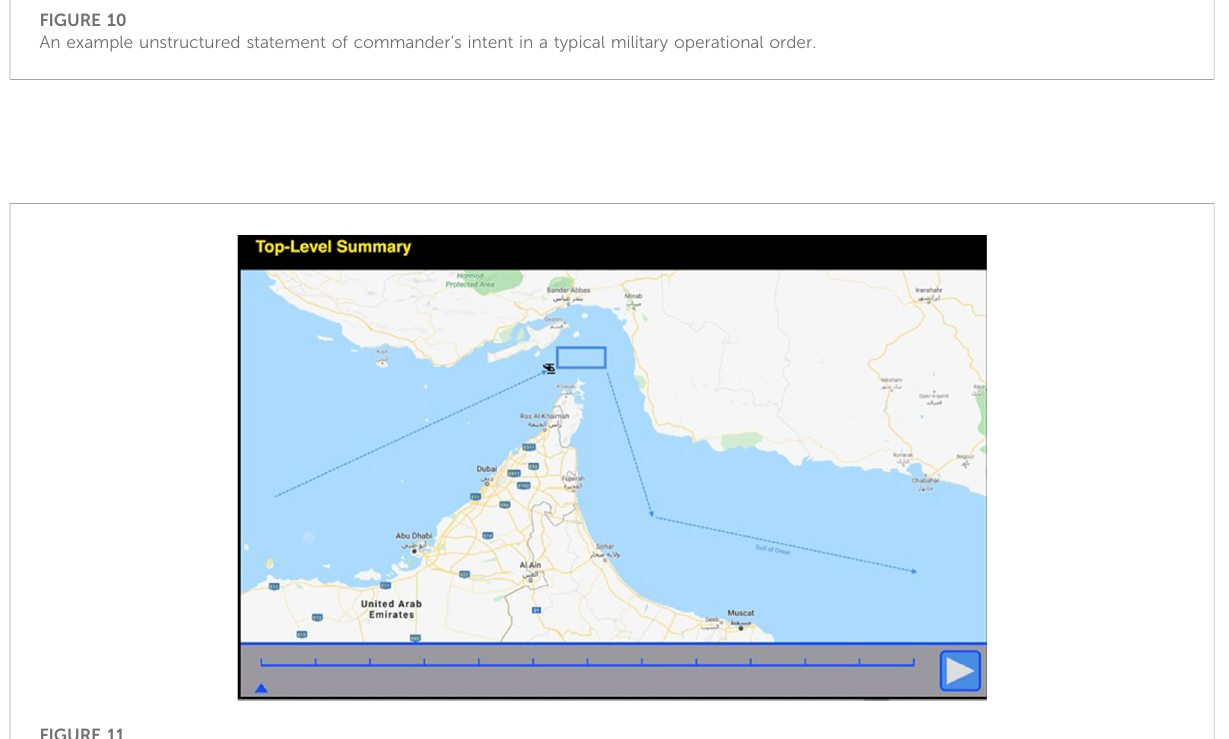
Visual component of the top level summary of a